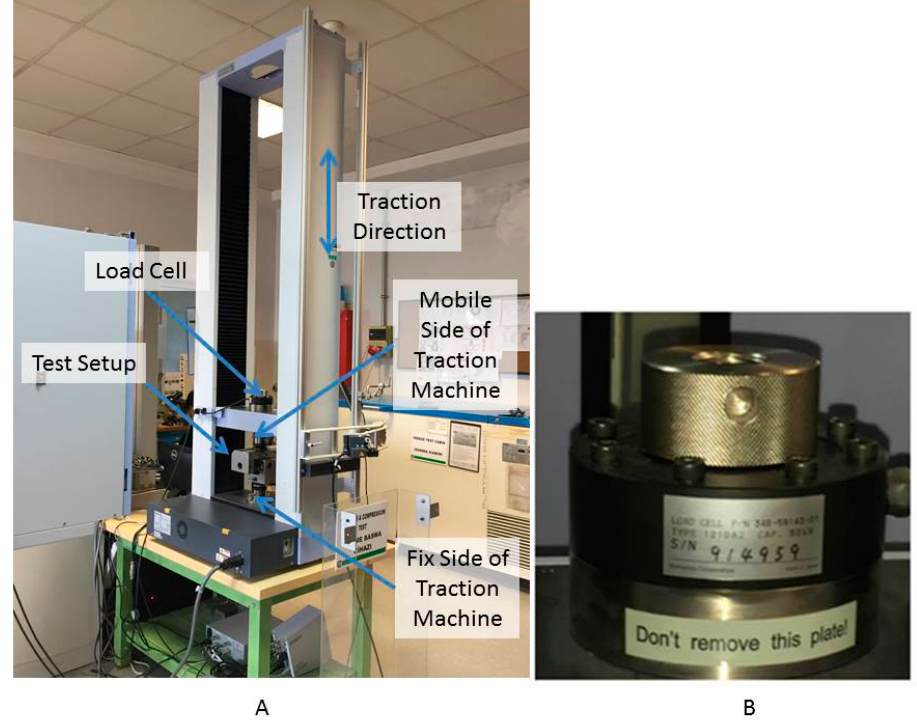
Figure 18. Tensile test machine configurations (( A ) tensile test machine, ( B ) load cell).